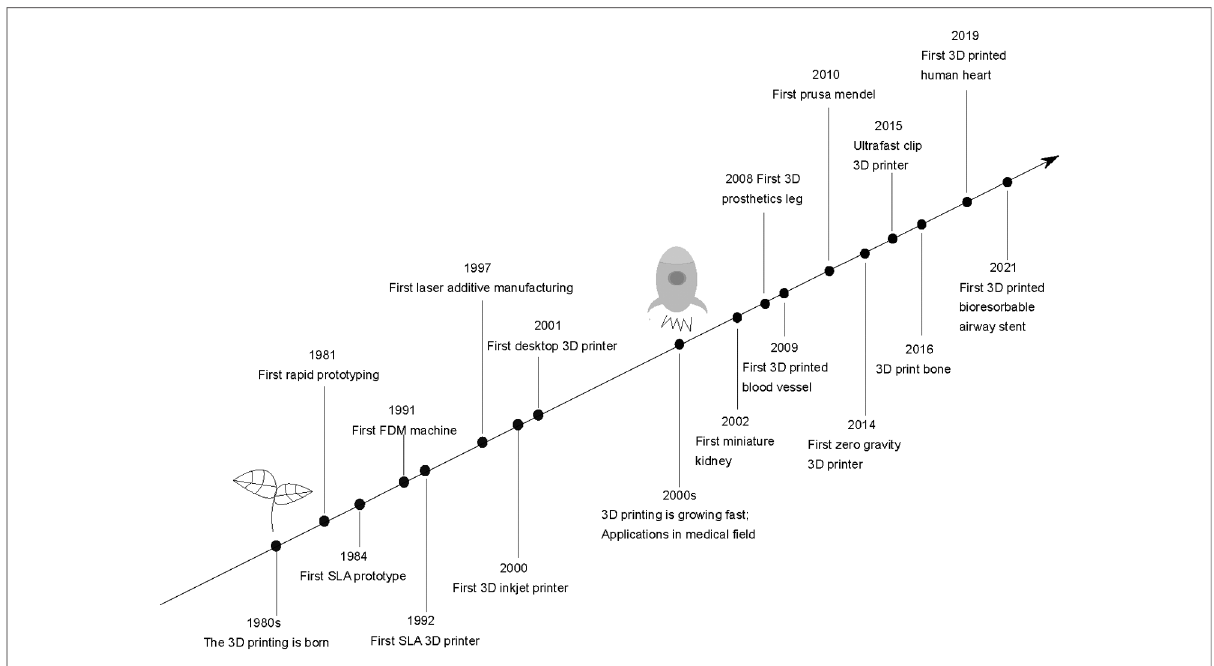
FIGURE 1 Timeline of 3D printing